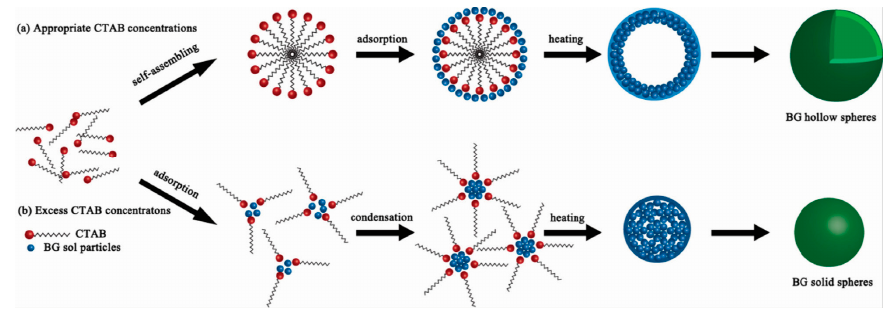
Figure 5. Schematic illustration of the formation processes of hollow mesoporous bioactive glass sub-micron spheres (HMBGS) [71].